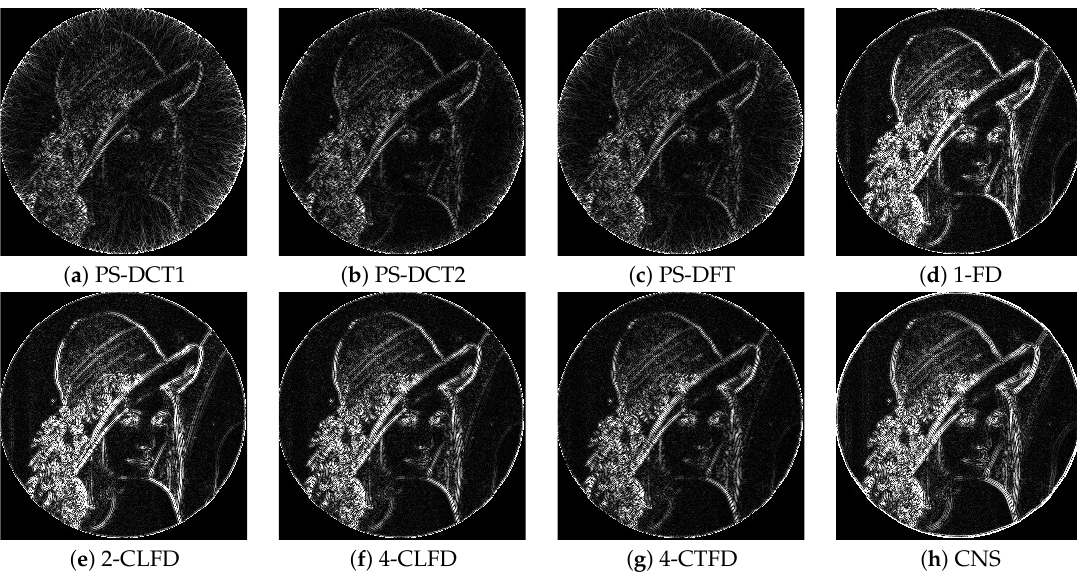
Figure 6. The absolute errors of the final output after successive rotation of the image